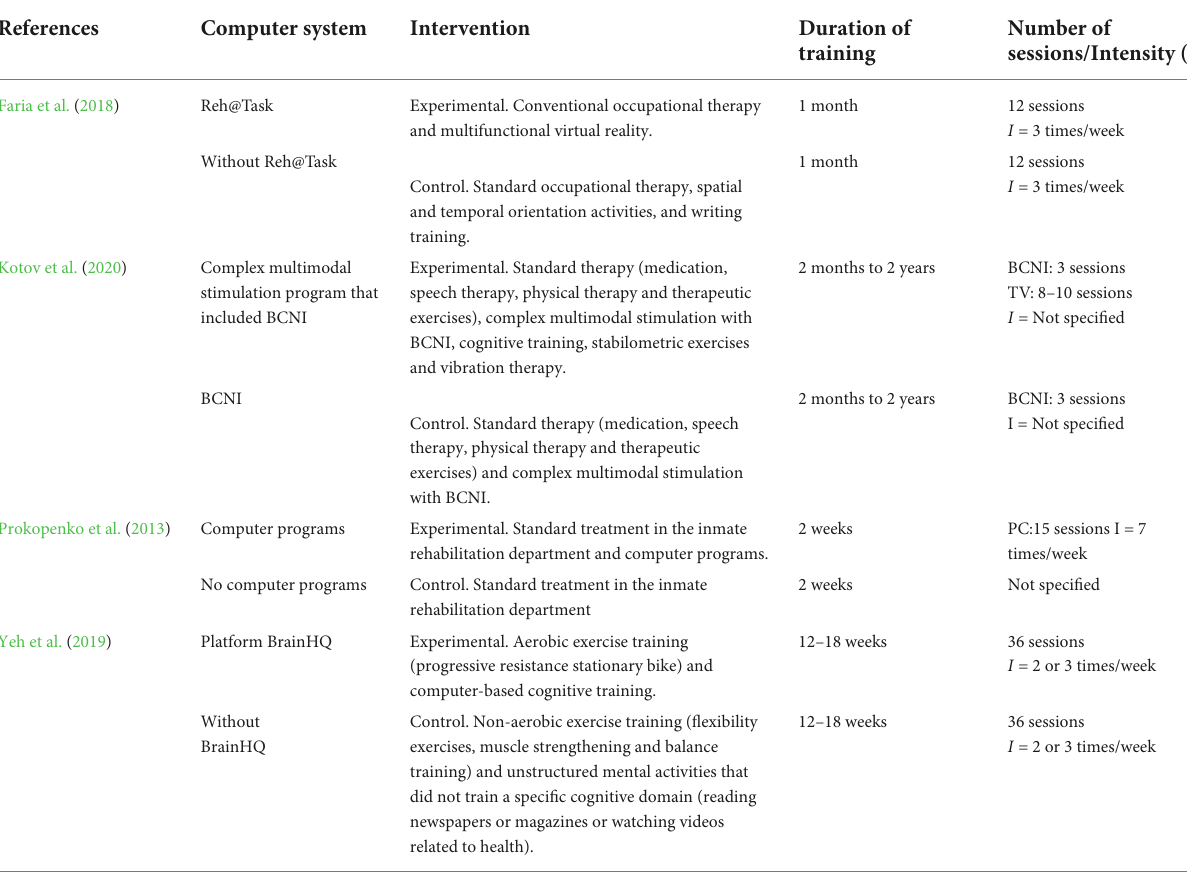
TABLE 2 Intervention